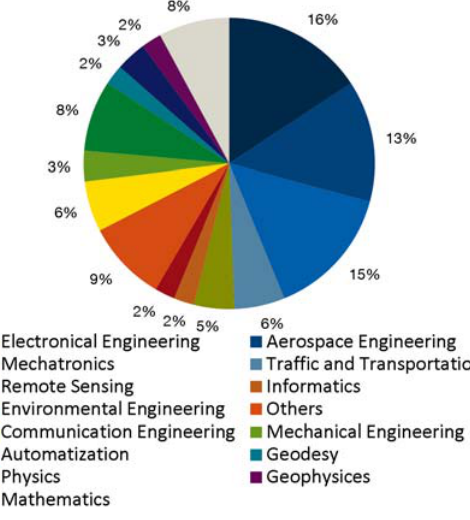
Figure 1. Final degree held by enrolled ESPACE students 2.4.1